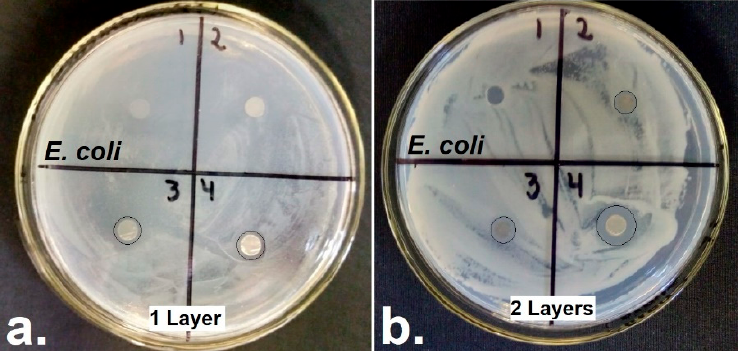
Figure 12. Inhibition zone of the PEEK (1), PEEK/Ag0.04 (2), PEEK/Ag0.08 (3) and PEEK/Ag0.12 (4) coated with one layer (a) and two layers (b) of silver with Escherichia coli .